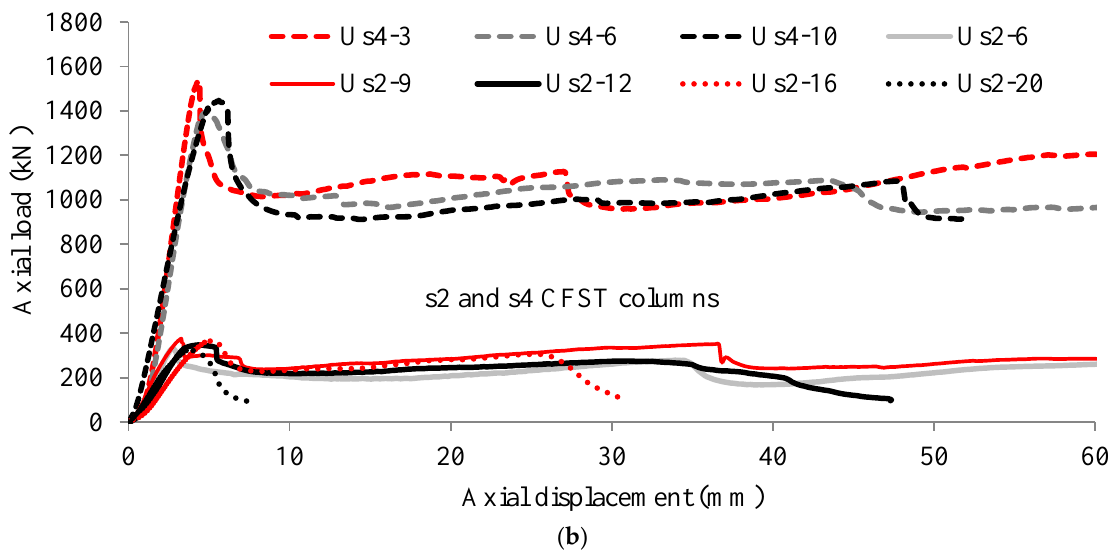
Figure 4. ( a ): Load-displacement responses of circular (CI and CII) and rectangular CFST columns . ( b ): Load-displacement responses of square CFST columns.